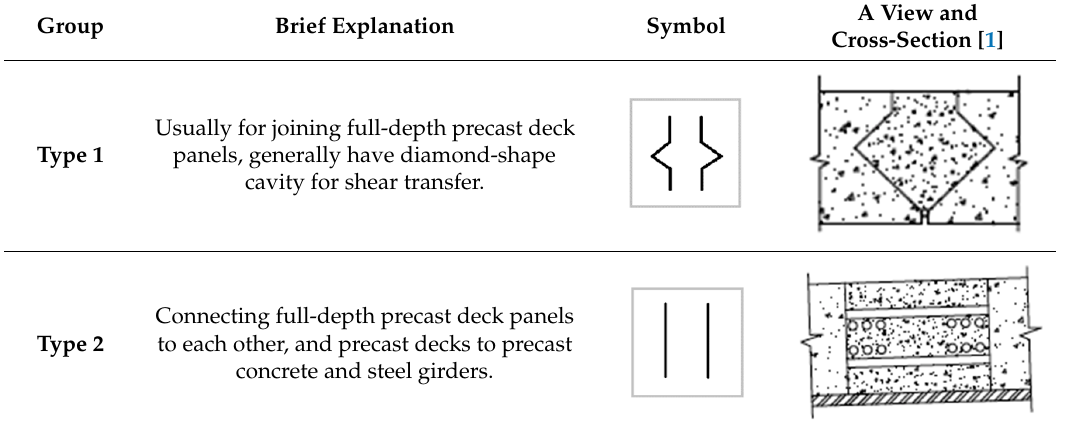
Table 1. Grouping of ABC closure Joints.